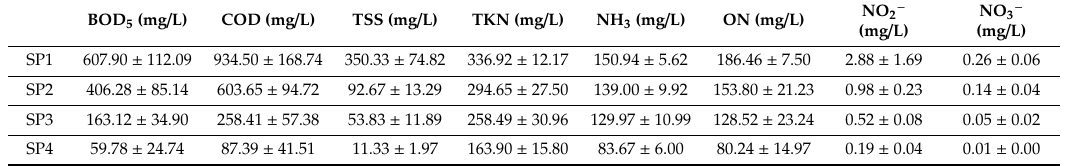
Table 1. Average values of water quality parameters measured at each sampling point.